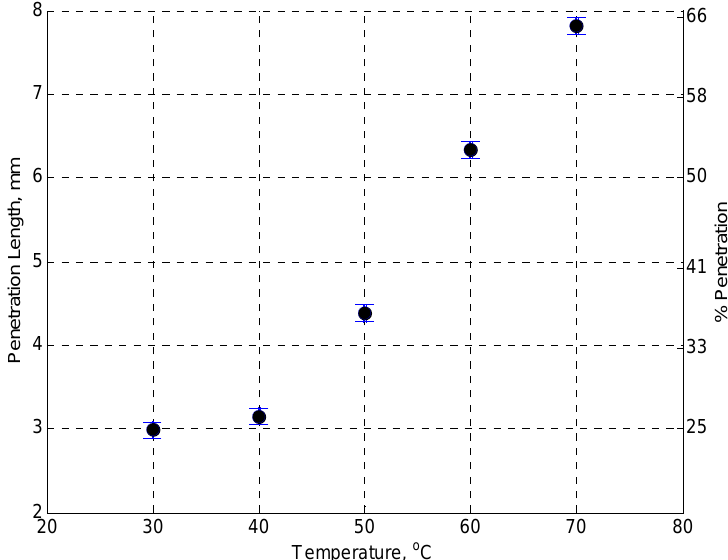
Figure 6. The penetration length of jelly into the pie crust with a concentration time of 90 minutes plotted as a function of the jelly temperature. The right hand axis shows this as a percentage of the total thickness of the